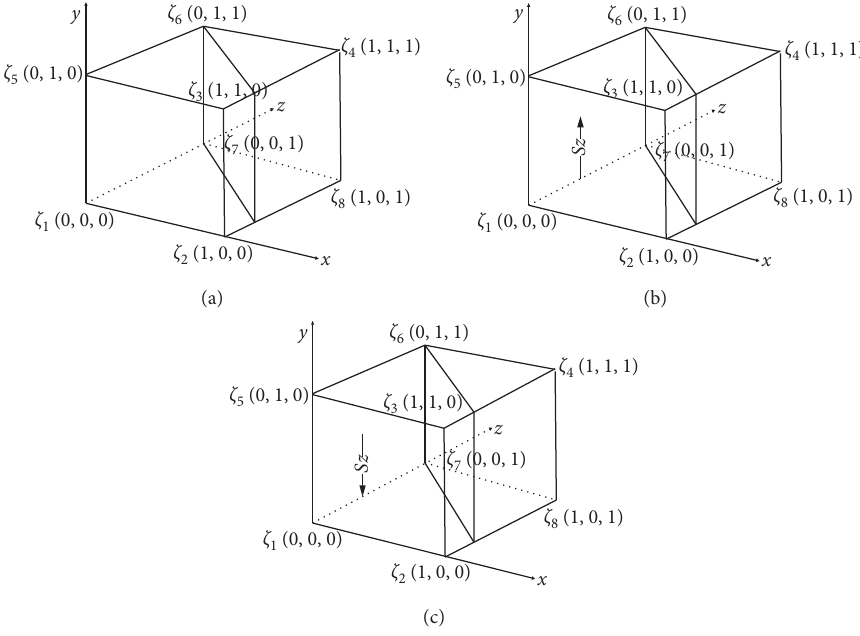
Figure 9: End user stability evolution phase